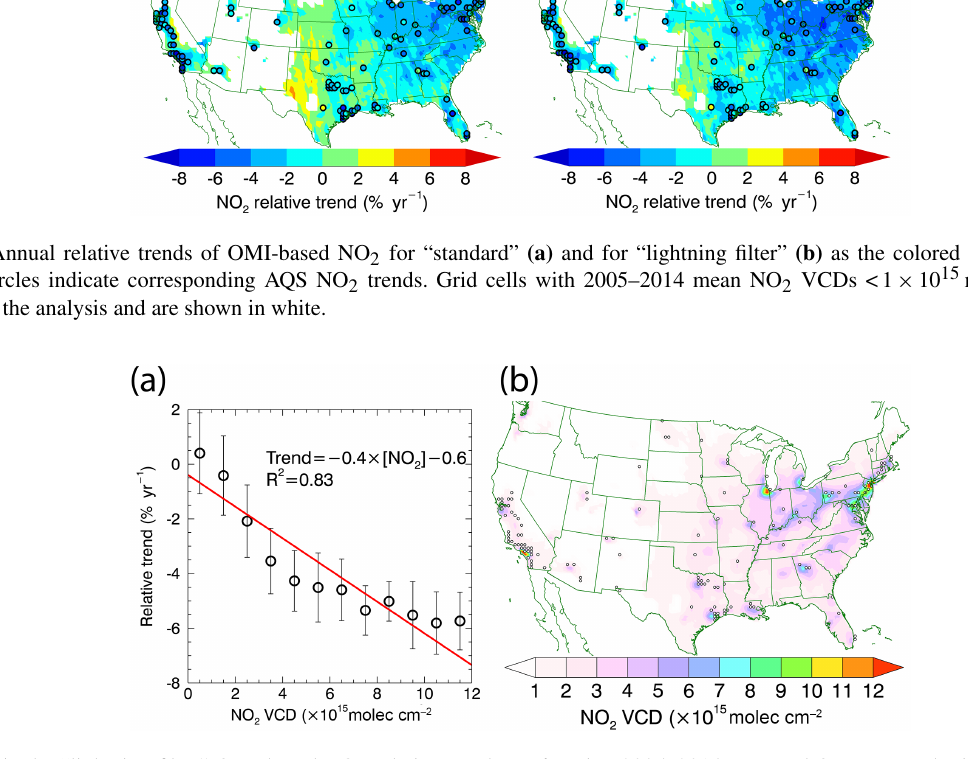
Figure 9. (a) The “lightning filter” OMI-based NO 2 relative trend as a function 2005–2014-averaged OMI tropospheric NO 2 VCD binned every 1 × 10 15 moleccm 2 . The error bars represent 95th-percentile confidence intervals. The red line shows a least-squares regression. (b) The distribution of 2005–2014-averaged OMI tropospheric NO 2 VCD. Black-bordered circles represent AQS sites. The OMI tropospheric NO 2 data (“lightning filter”) are